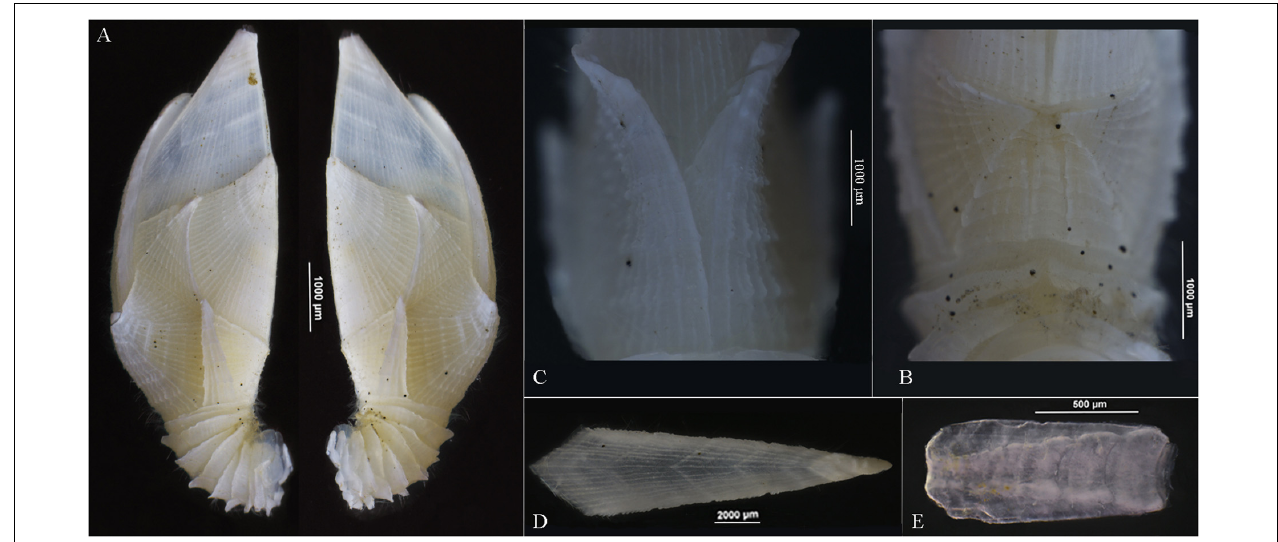
FIGURE 2 | Arcoscalpellum angularum sp. nov. holotype. (A) Lateral views. (B) Rostrum in situ . (C) Carinal view of carinolatus. (D) Carina. (E) Rostrum.